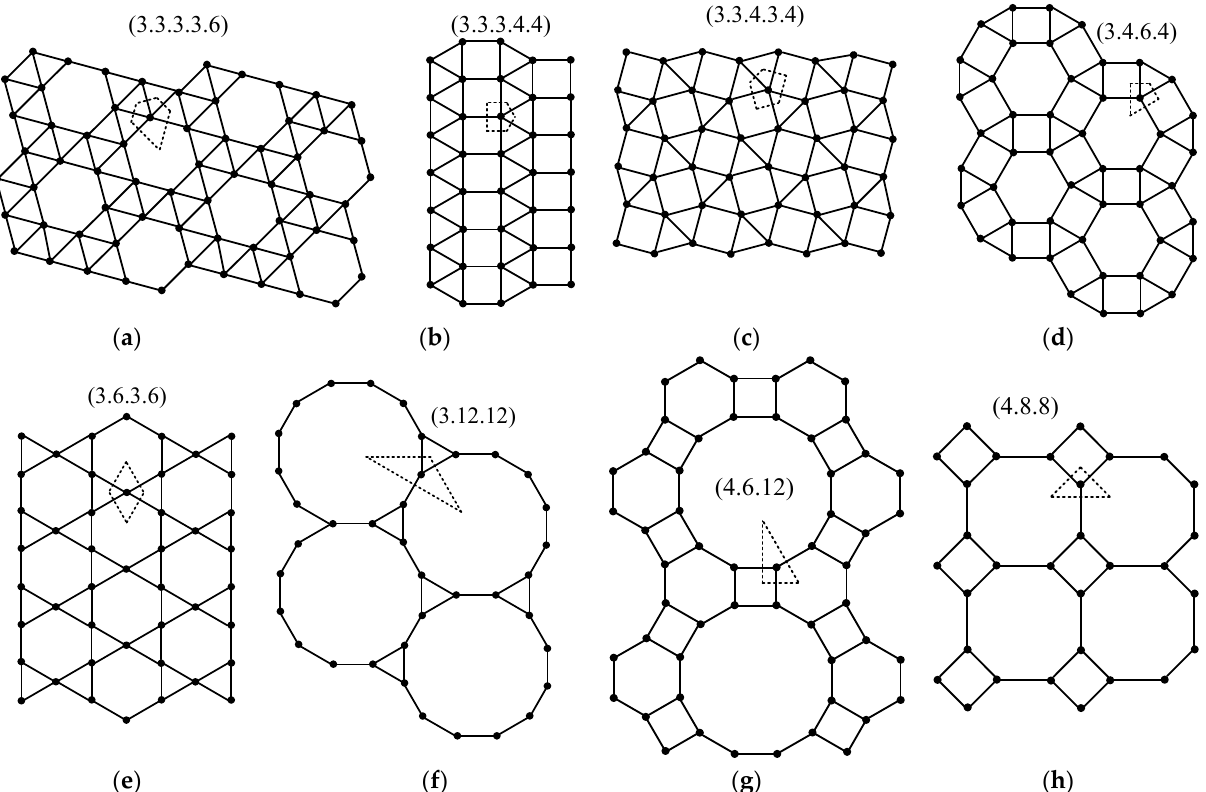
Figure 3. Proposed eight lattice converters based on Archimedean tilings: ( a ) (3.3.3.3.6); ( b ) (3.3.3.4.4); ( c ) (3.3.4.3.4); ( d ) (3.4.6.4); ( e ) (3.6.3.6); ( f ) (3.12.12); ( g ) (4.6.12); ( h )